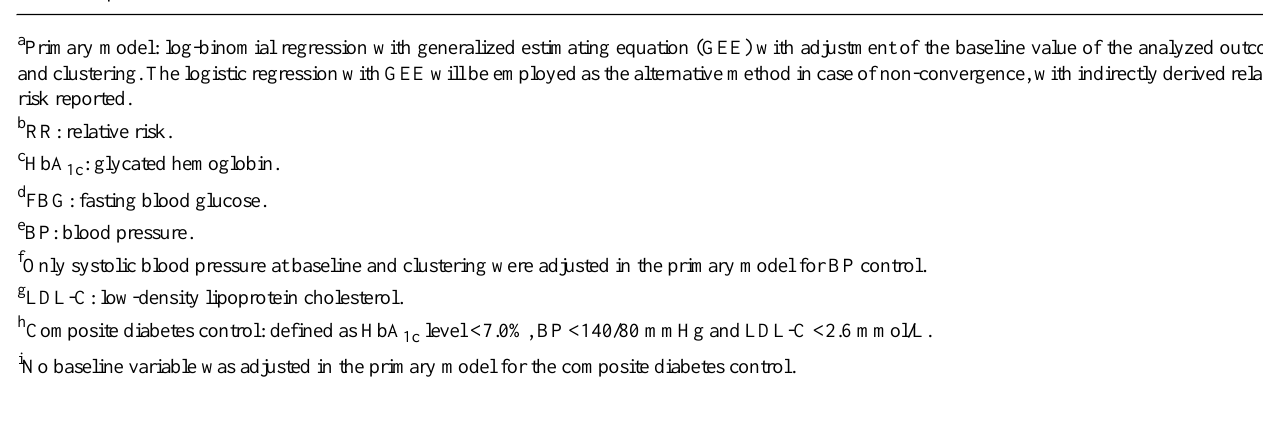
Table 3. Estimated effects of intervention compared to control on the change from baseline of continuous outcomes.